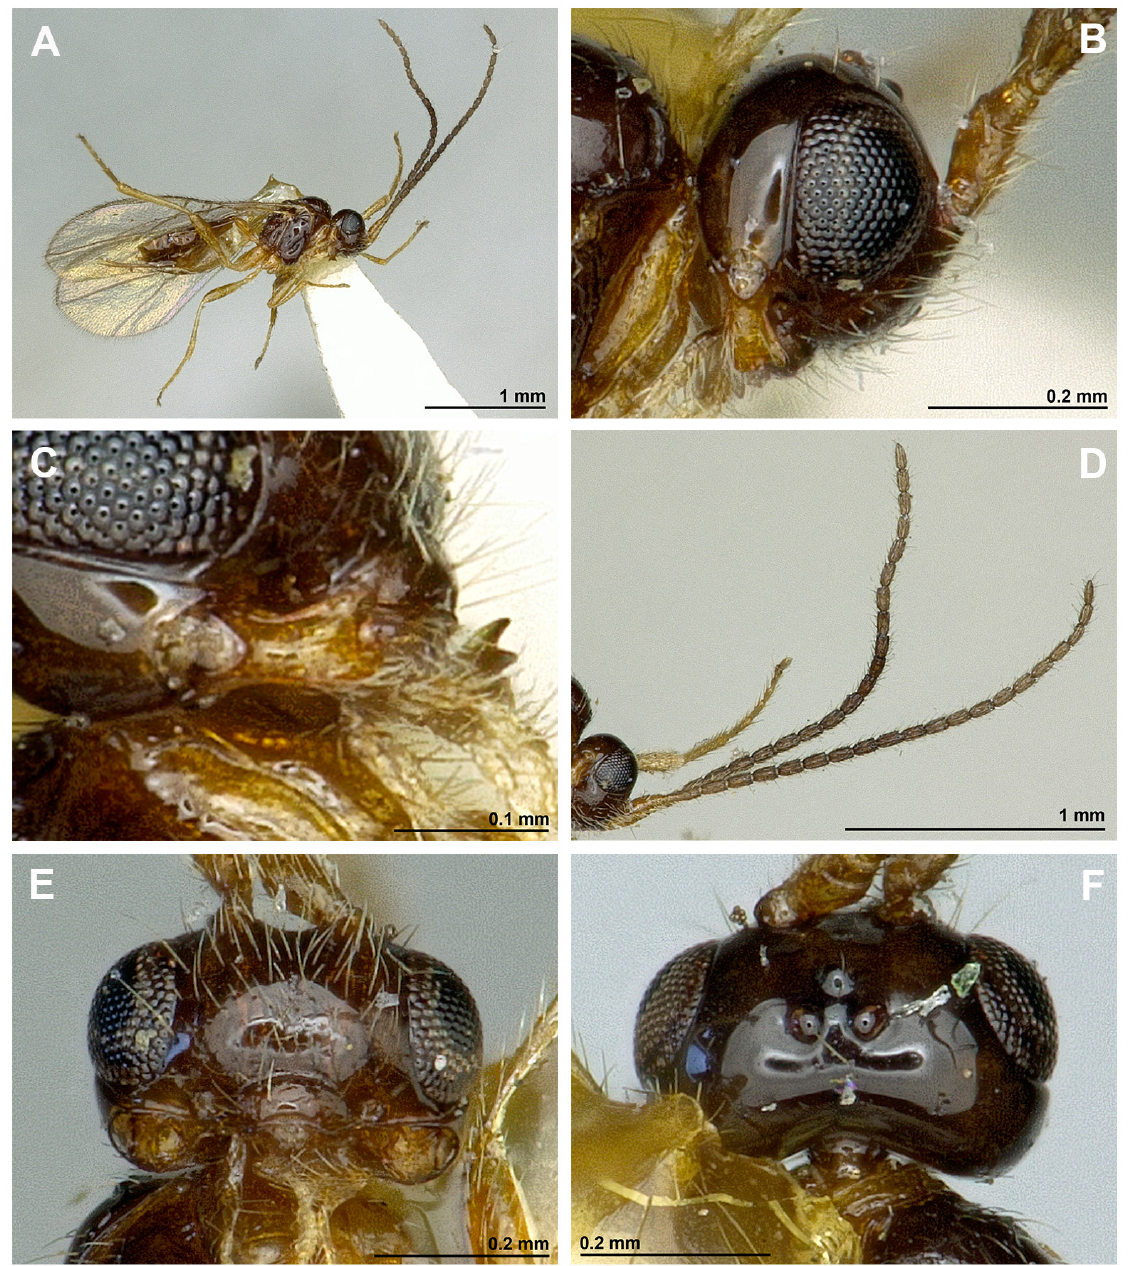
Fig. 10. Synaldis novateutoniae Peris-Felipo, sp. nov., ♀. A . Habitus, lateral view. B . Head, lateral view. C . Mandible. D . Antenna. E . Face, front view. F . Head,